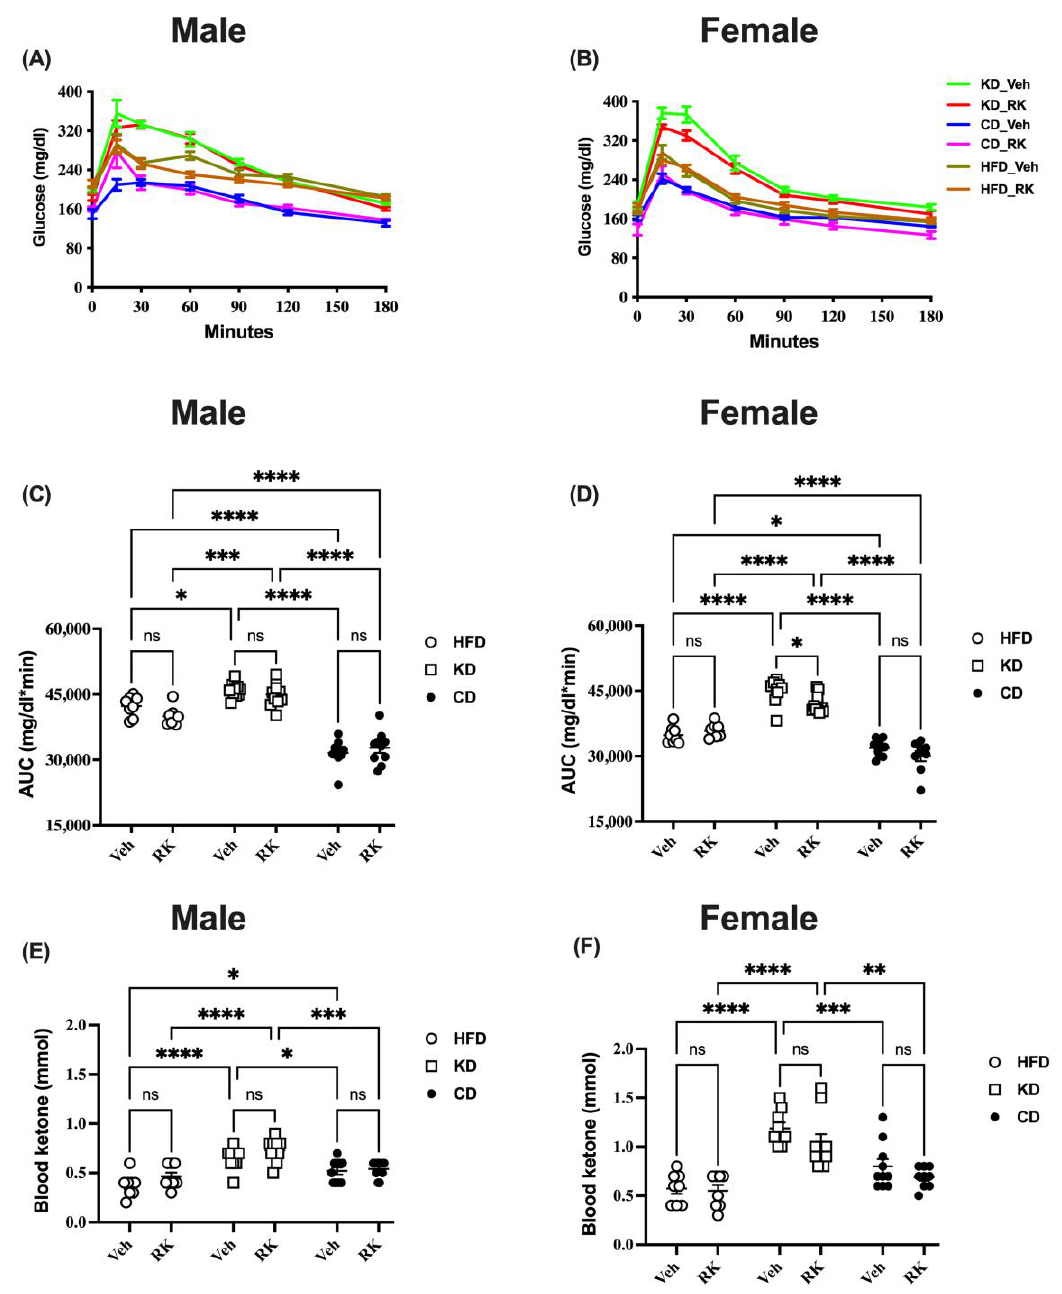
Figure 2. Oral glucose tolerance test ( A , B ), glucose area under the curve (AUC) ( C , D ) and blood ketone levels ( E , F ) in male and female mice after 3 weeks of daily dosing and diet feeding. Data are represented as mean± standard error of the mean (SEM * p < 0.05; ** p < 0.01; *** p < 0.001; **** p < 0.0001; ns, not significant; Two-way analysis of variance (ANOVA) was performed, followed by Newman-Keuls post hoc tests when justified; p < 0.05 was considered statistically significant. N = 8-10 mice/group. High-fat diet (45%fat), HFD; ketogenic diet (80%fat), KD; control diet (10%fat), CD; vehicle, Veh; raspberry ketone, RK.